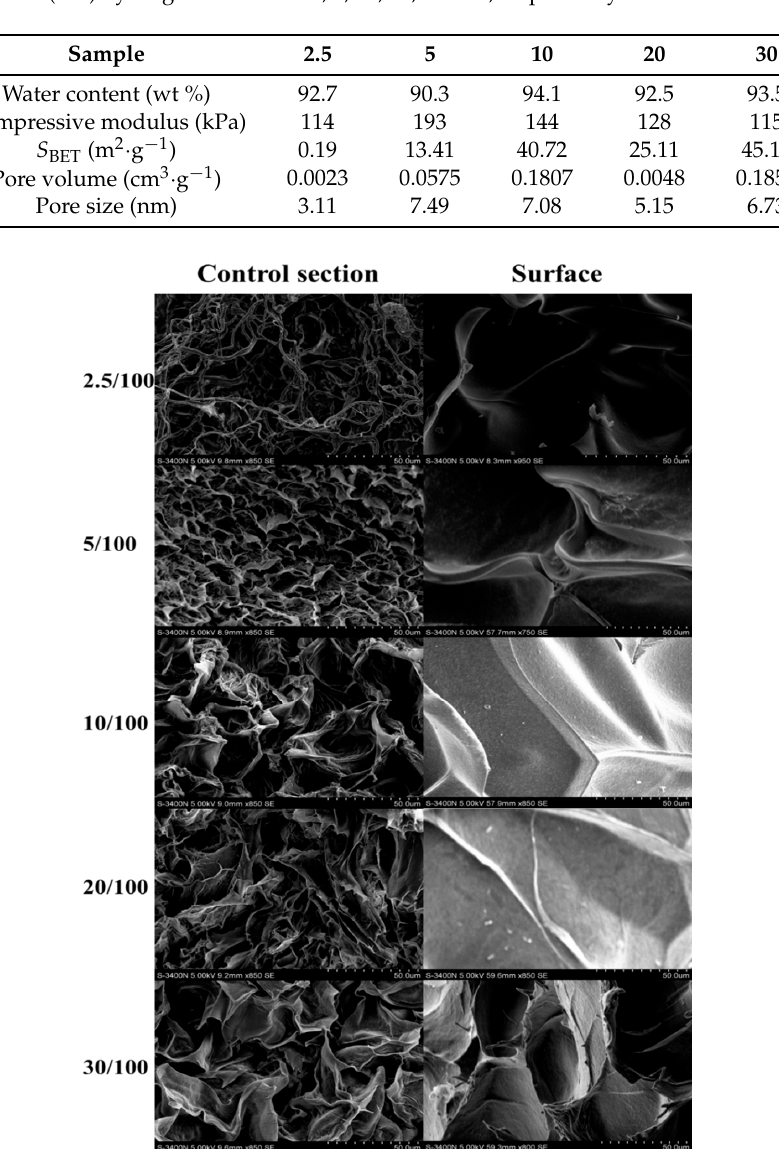
Figure 4. SEM images of GO( x )/cellulose(100) dry hydrogels with x = 2.5, 5, 10, 20, and 30, respectively. Cross-section images were taken inside the gel. Surface images were taken on the surface of the hydrogels.